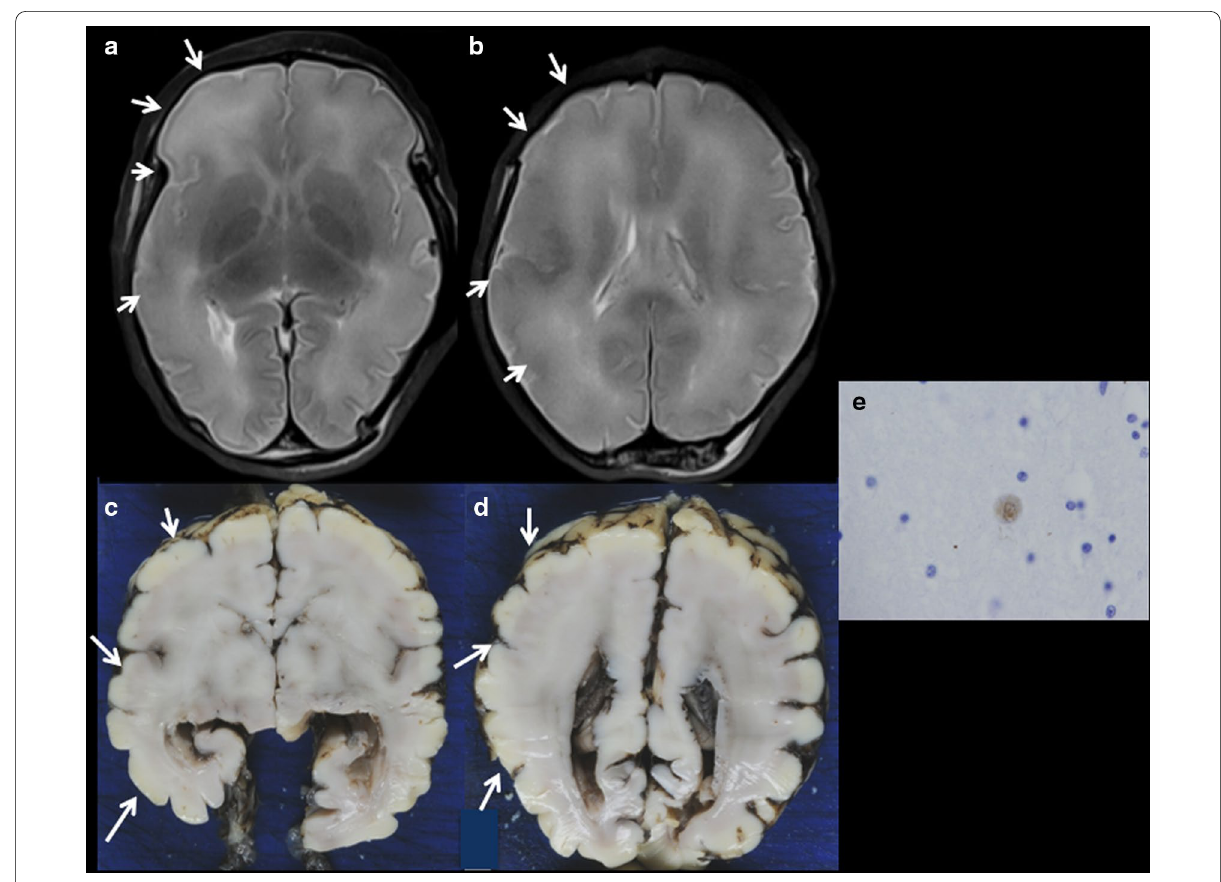
Fig. 13 NMD in a 35‑week foetus with elective termination of pregnancy due to CMV infection. a , b Axial T2W MRI showing a neuronal migration disorder in the right hemisphere (pachygyria), (arrows). c , d Macroscopic specimen showing pachygyria (arrows) and ( e ) positive cell against CMV immunohistochemistry ( ×